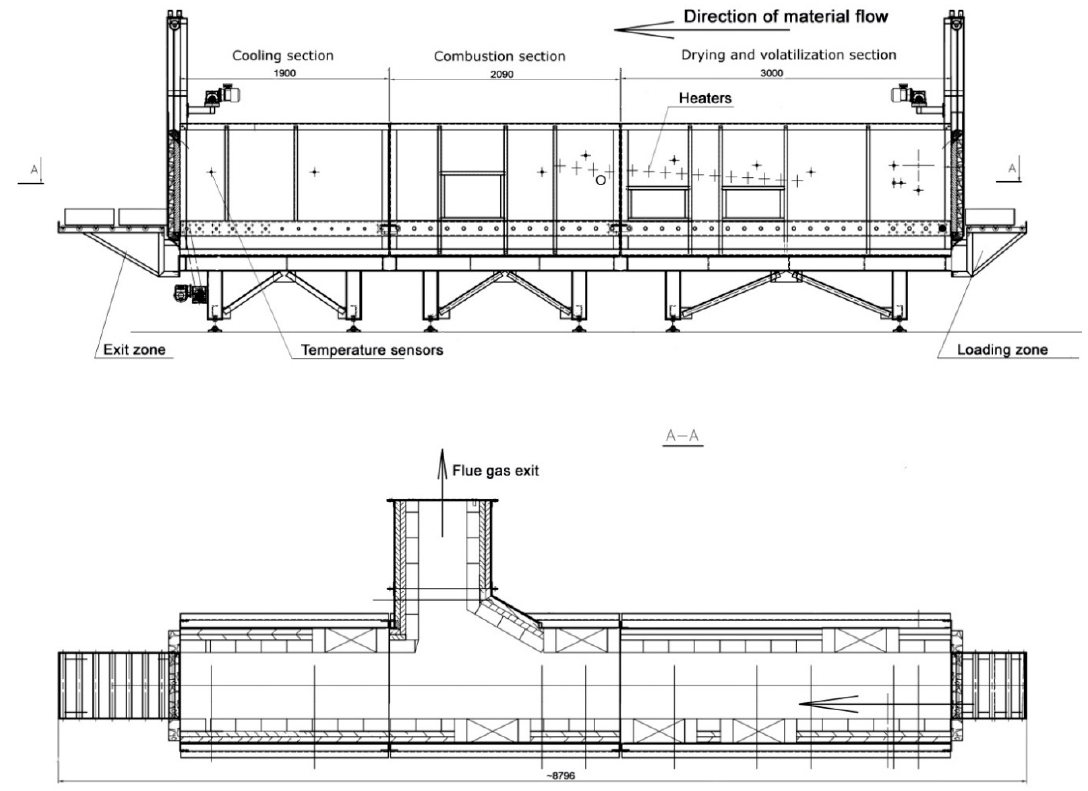
Figure 2. A scheme of the tannery waste incinerating installation.